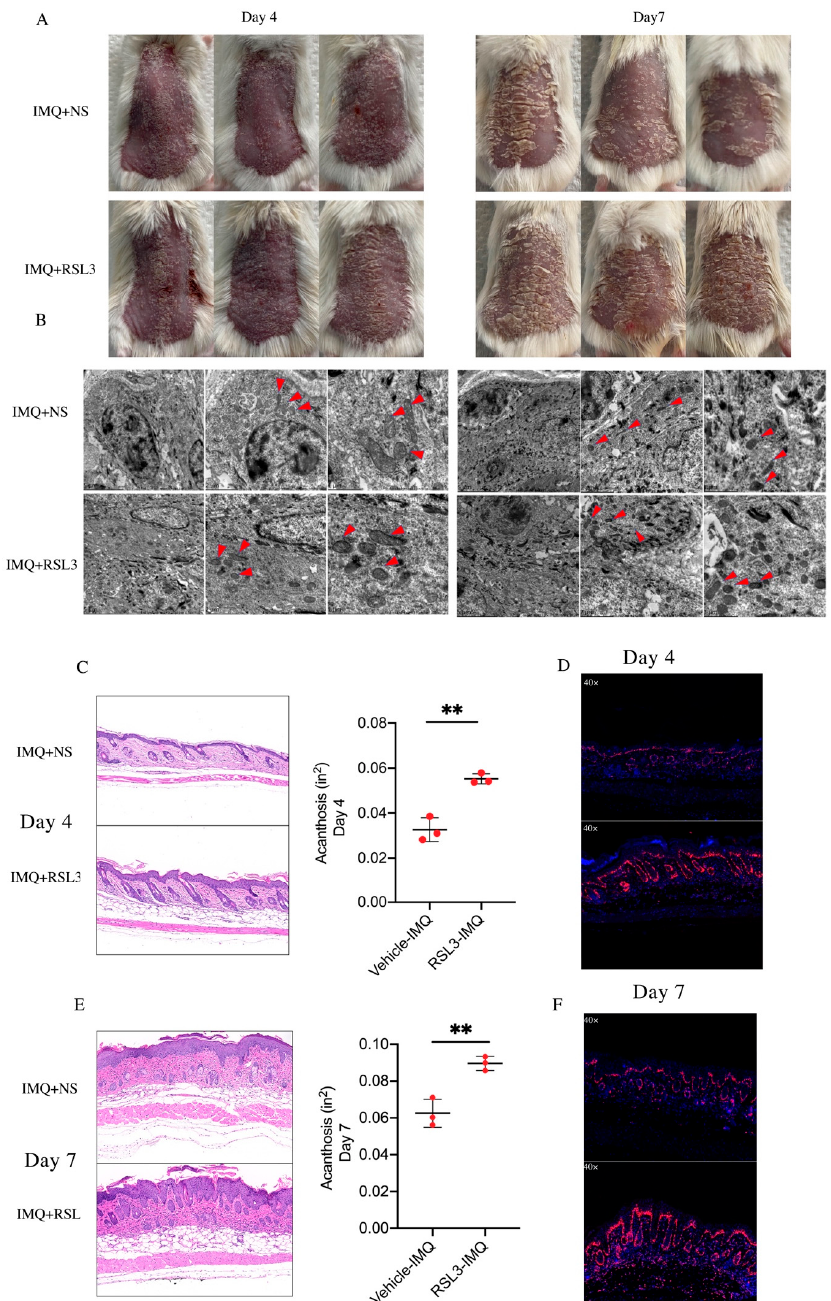
Figure 2. IMQ-induced psoriasis-like mice stimulated by ferroptosis inducer RSL3. ( A ) Phenotypic presentation of lesional skin from mice injected with RSL3 and saline on day 4 and day 7. ( B ) Rep- resentative TEM images of epidermis tissues derived from mice injected with RSL3 and saline on day 4 and day 7 (red triangles indicate mitochondria). ( C ) Representative H&E staining image and acanthosis assessment of lesions from mice injected with RSL3 and saline on day 4. Scale bars: 100 µ m. Acanthosis of mice treated with NS ( n = 3) or RSL3 ( n = 3). ( D ) Representative immunohistochemical analysis of Ki-67+ cells in skin samples on day 4. ( E ) Representative H&E staining image and acantho- sis assessment of lesion from mice injected with RSL3 and saline on day 7. Acanthosis of mice treated with NS ( n = 3) or RSL3 ( n = 3). Scale bars: 100 µ m. ( F ) Representative immunohistochemical analysis of Ki-67+ cells in skin samples on day 7. Data represent the mean ± SEM, ** p < 0.01. Two-tailed Mann—Whitney U test was